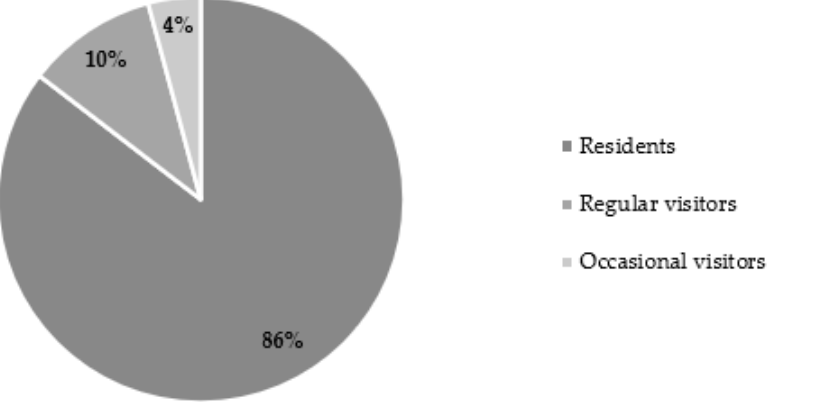
Figure 6. Distribution of the age of the dead victims-October 2017 [17]. The analysis of the relationship of the victims with the place of death shows that 86% of the victims were residents. In addition, since most victims were old people, they ended up dying either inside their homes or nearby (Figure 7).